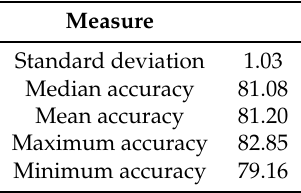
Table 8. SVM3 (reduced feature set using PCA).